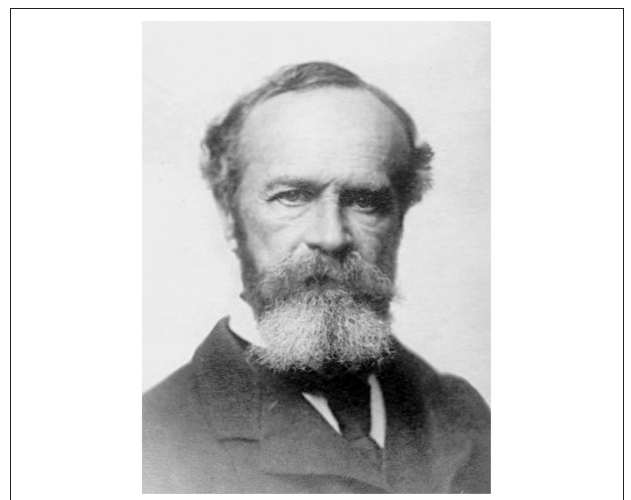
FIGURE 4 | William